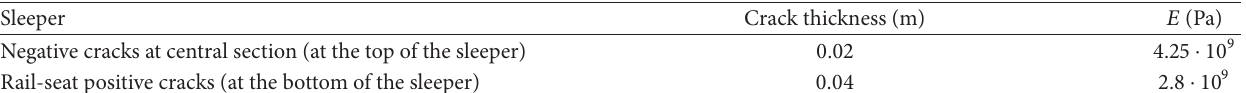
Table 2: Crack properties.